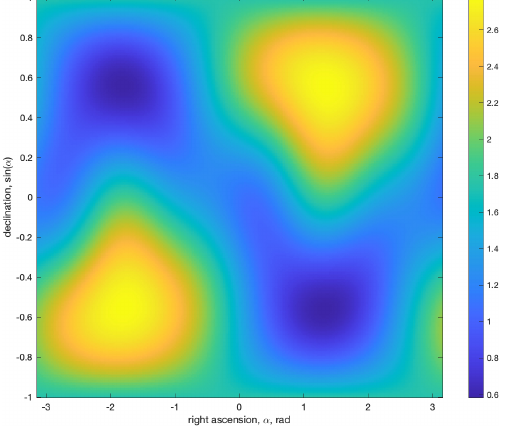
Figure 5. EAN network power pattern for the optimal angle.